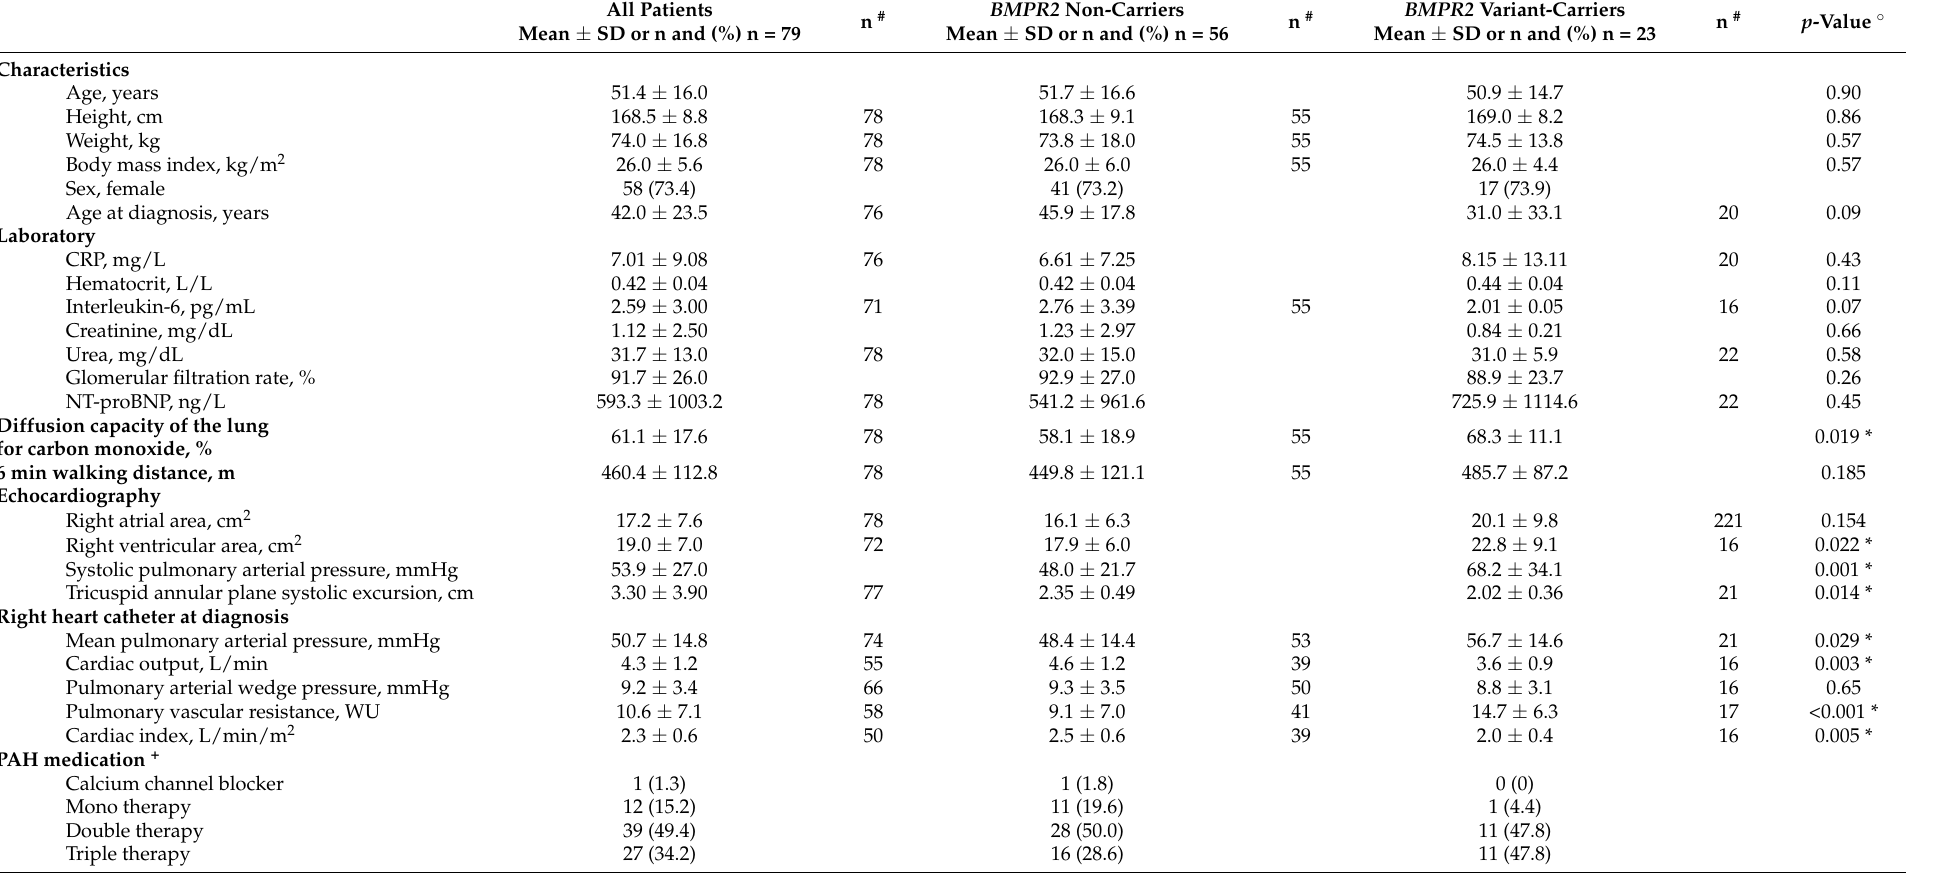
Table 1. Baseline characteristics of PAH